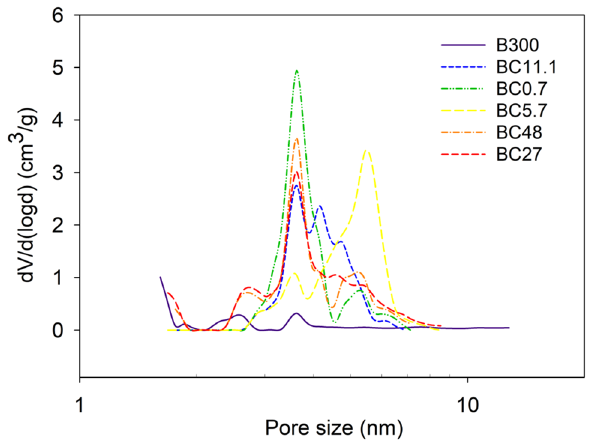
Fig. 4 Pore size distribution of the